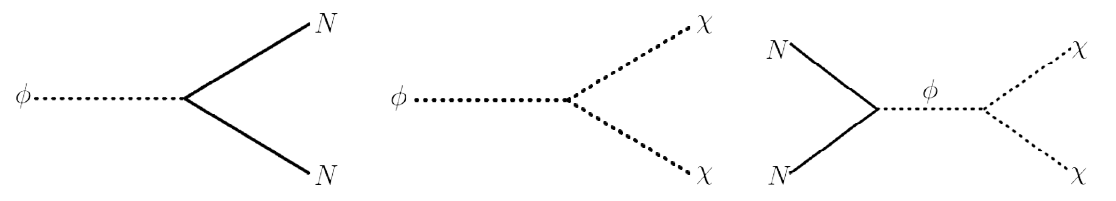
Figure 7 . The Feynman diagrams for the Majorogenesis in the scenario